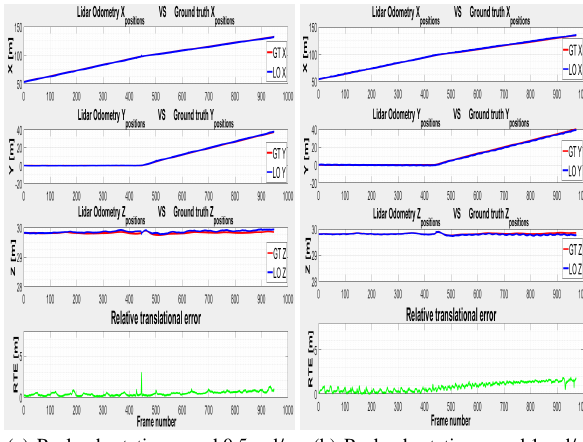
Figure 12. Experience of varying the payload rotation speed in a moving drone mode